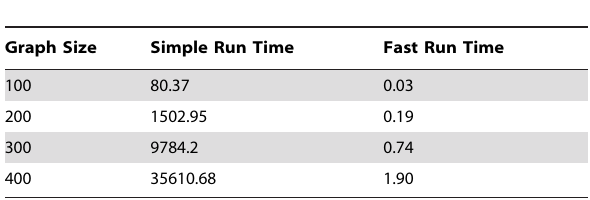
Table 5. Runtime of GREEDY- C LC vs GREEDY- C LC